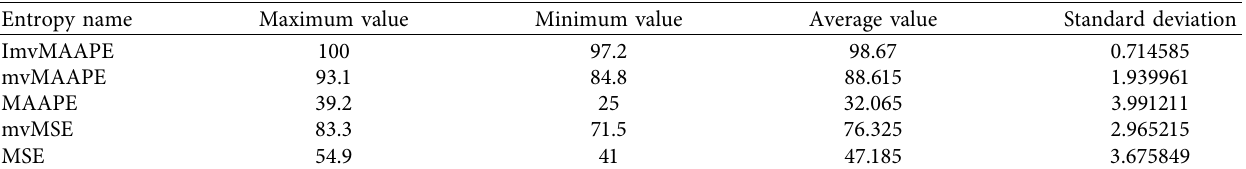
Figure 20: The performance comparison of the two-dimensional feature vectors reduced by the t-SNE method of the bearing’s 10 working conditions extracted by ImvMAAPE (a), mvMAAPE (b), and MAAPE (c) algorithms. Table 5: The gearbox experiment results of different